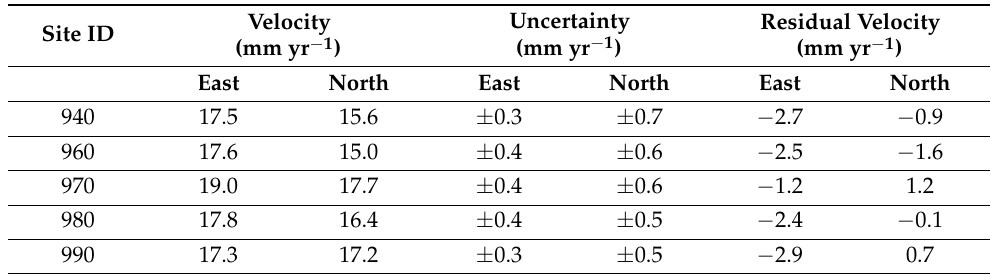
Table 1. Absolute velocity field in IGS14 reference frame and residual velocity field with respect to stable Eurasia based on the ITRF2014